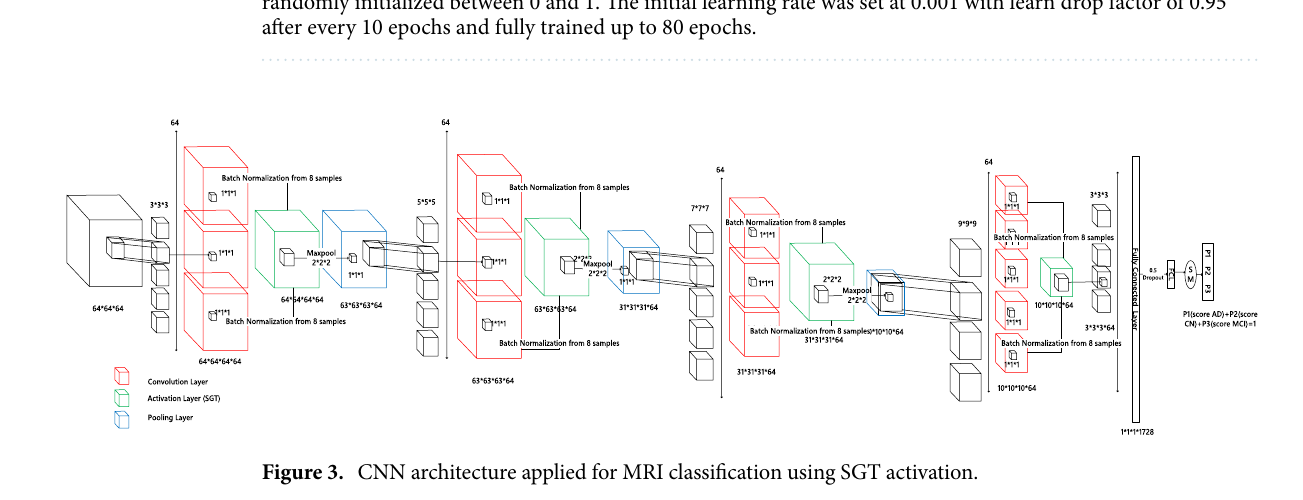
Figure 3. CNN architecture applied for MRI classification using SGT